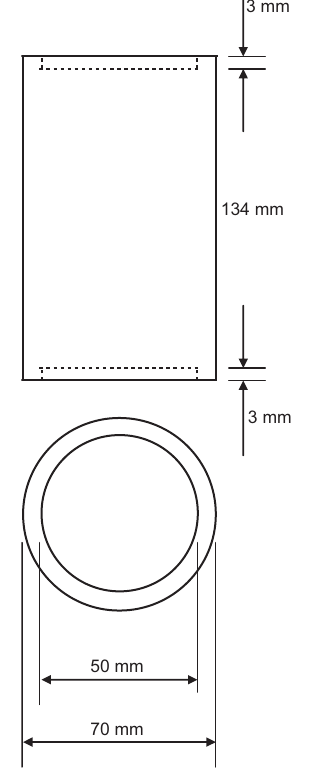
Figure 2 The confi guration of the rimmed